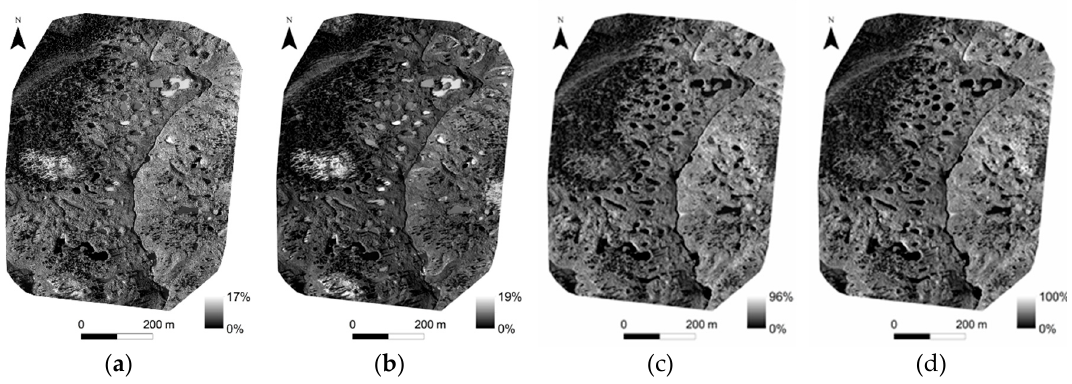
Figure 4. UAS survey derived reflectance for KWAK (31/08/2017, 17:00): ( a ) Green (530–570 nm); ( b ) Red (640–680 nm); ( c ) Red Edge (740–740 nm); ( d ) Near Infrared (770–810 nm).